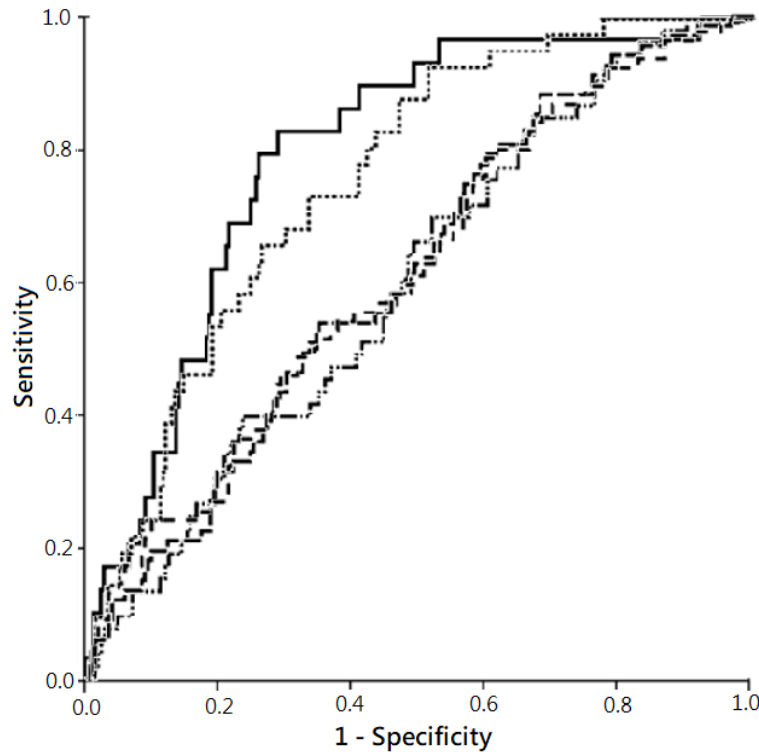
Figure 4. Predictivities for all-cause mortality by plasma N-terminal pro-brain natriuretic peptide (NT-proBNP) levels in varied follow-up periods, with risk factor adjustment. Note: The comparison was performed using receiver operating characteristic (ROC) curve. The plot showed the highest predictability for all-cause mortality in 1-month follow-up (solid line; area under the curve (AUC) of ROC (AUC ROC), 0.79; 95% confidence interval (CI), 0.71 – 0.87; p <0.001)), followed subsequently by 3-month follow-up (dotted line; AUC ROC, 0.76; 95% CI, 0.69 – 0.83; p <0.001), 9-month follow-up (dash-dotted line; AUC ROC, 0.62; 95% CI, 0.54 – 0.69; p = 0.005), 12-month follow-up (dashed line; AUC ROC, 0.62; 95% CI, 0.54 – 0.69; p = 0.004), and 6-month follow-up (dash-solid line; AUC ROC, 0.61; 95% CI, 0.53 – 0.69; p = 0.016).